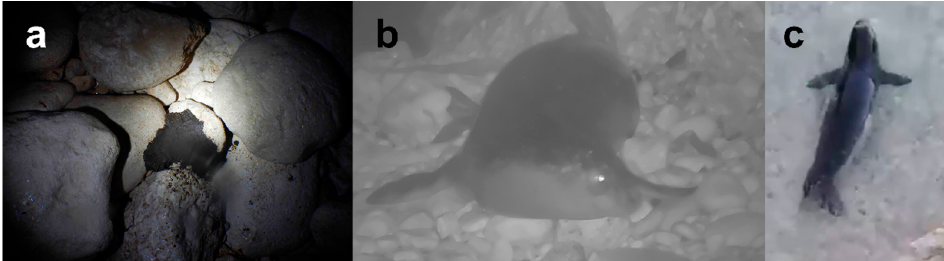
Figure 2. ( a ) Mediterranean scat collected in cave 1; ( b ) picture of the monk seal specimen caught on infrared camera in cave 1; ( c ) picture extracted from a video of monk seal collected in 2019 by RAPA Vlorë within the cited citizen science project.